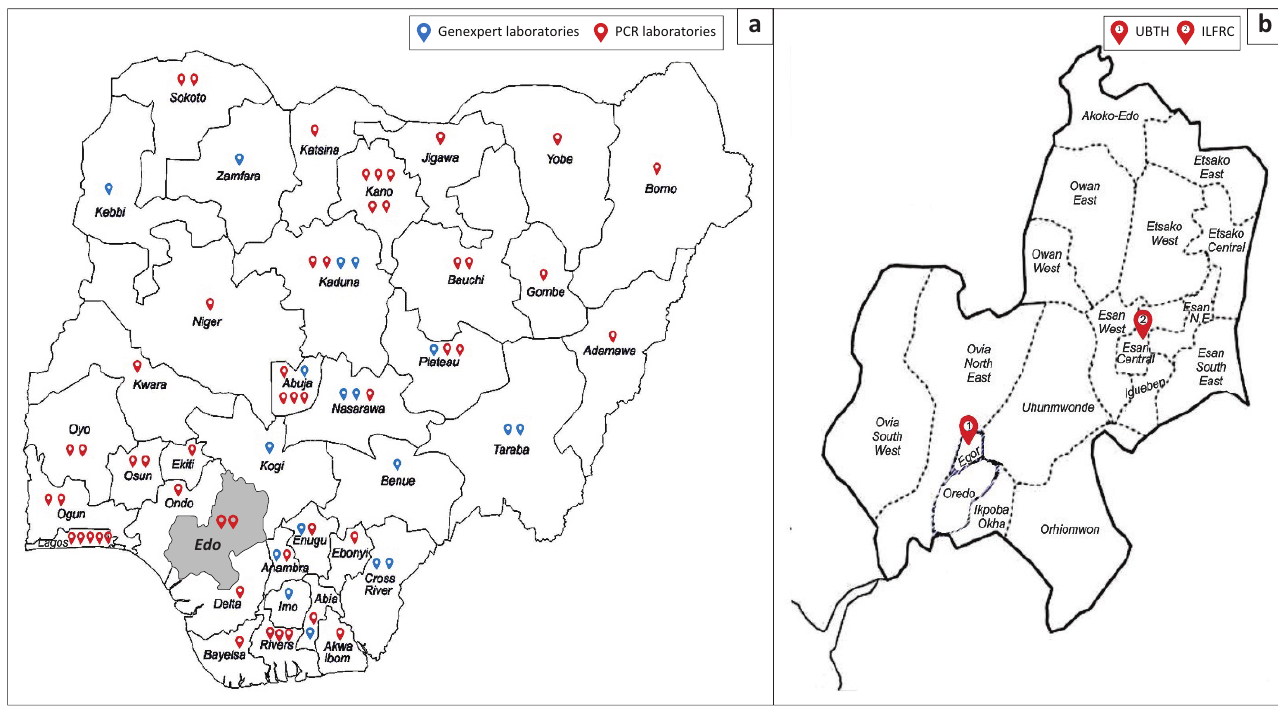
FIGURE 1 : COVID-19 laboratory network in Nigeria and Edo state, 2020. (a) Map of Nigeria showing Nigeria Centre for Disease Control COVID-19 molecular laboratory network (public laboratories only). (b) Map of Edo state showing local government areas and the locations of University of Benin Teaching Hospital molecular virology laboratory and the Institute of Lassa Fever Research and Control, Irrua Specialist Teaching